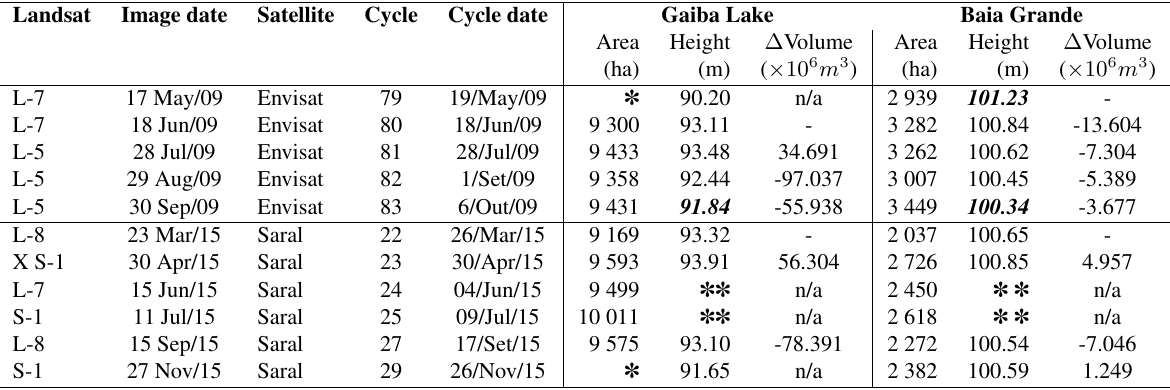
Table 2: Values of lake areas, water levels and volume fluctuations for Lake Gaiba and Lake Baia